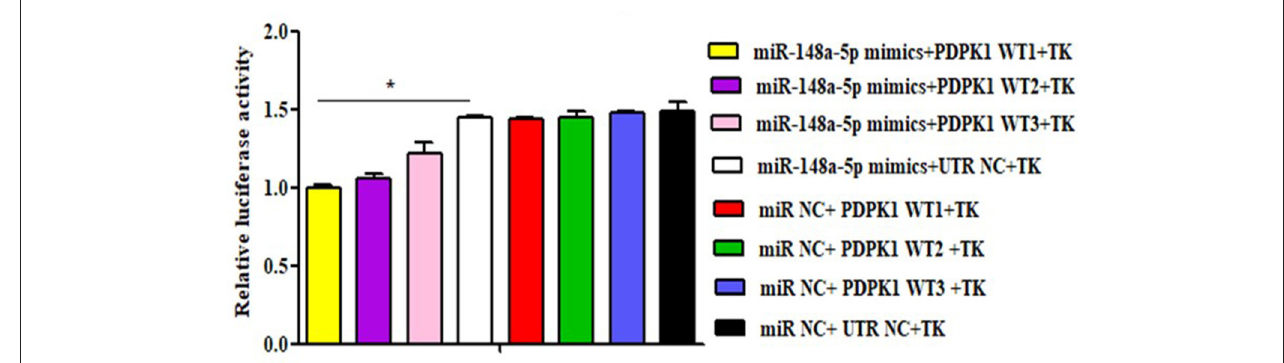
FIGURE 5 | Luciferase reporter assays in HEK 293 cells transfected with reporter vectors containing either the wild-type or blank plasmid vector. TK indicates renal internal reference; UTR NC indicates control for constructing 3 ′ -UTR reporter gene plasmid. The data are expressed as the mean ± SEM. * P < 0.05.